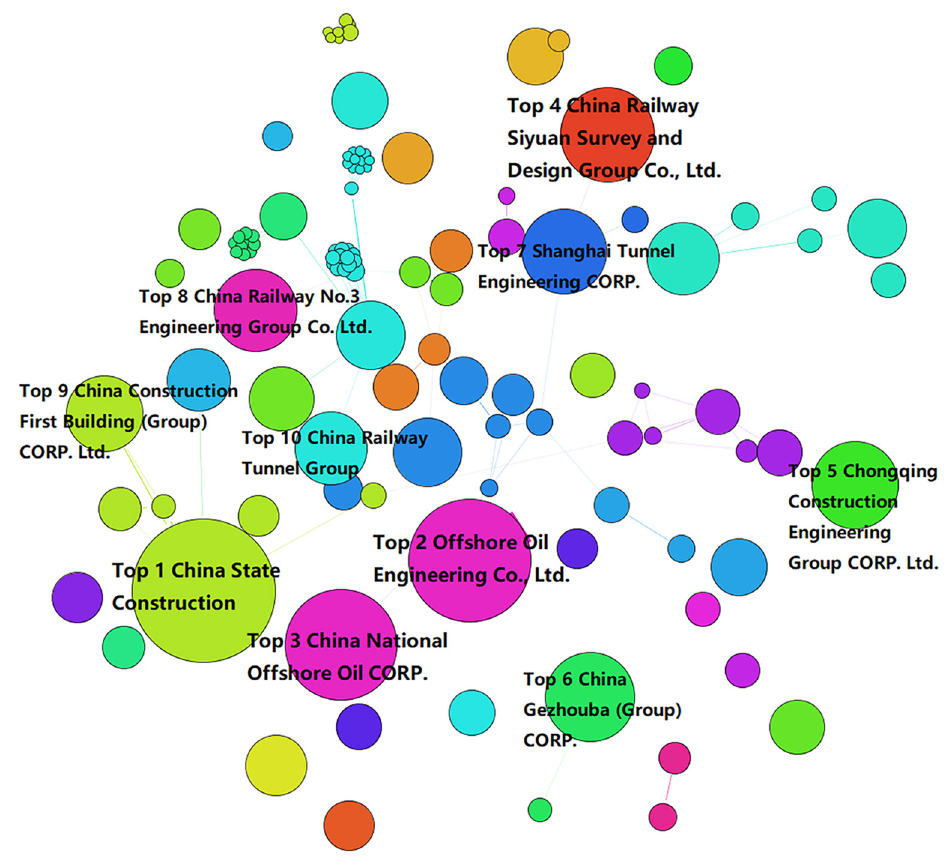
Figure 6. Enterprise-enterprise cooperative network